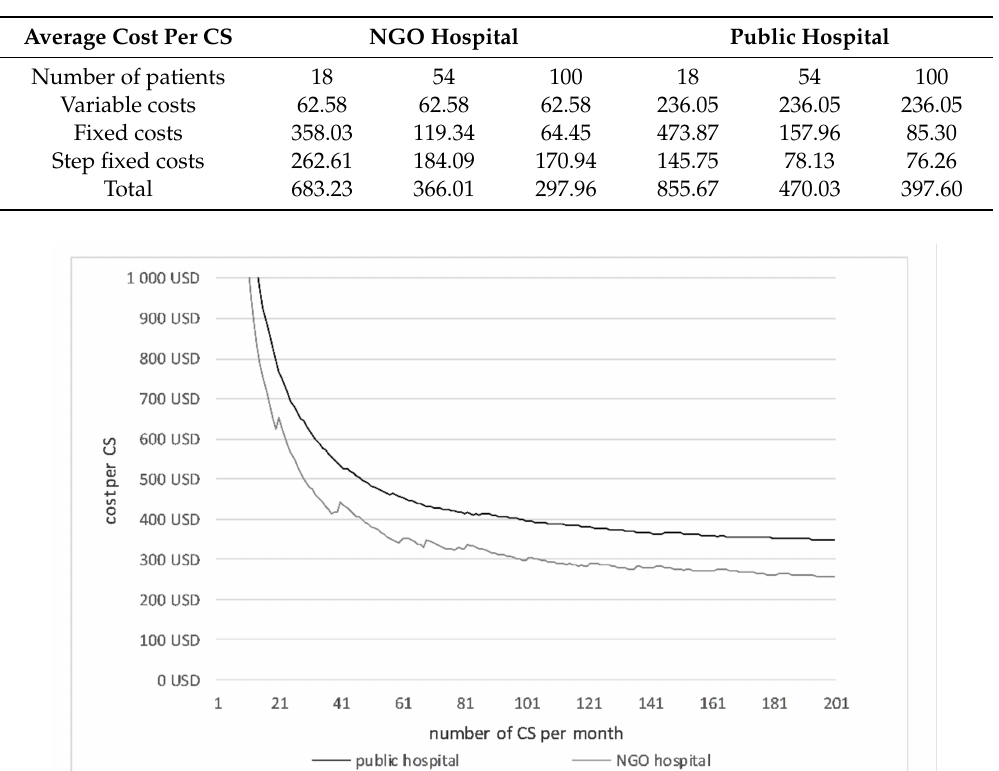
Table 8. Average cost per CS (US$).